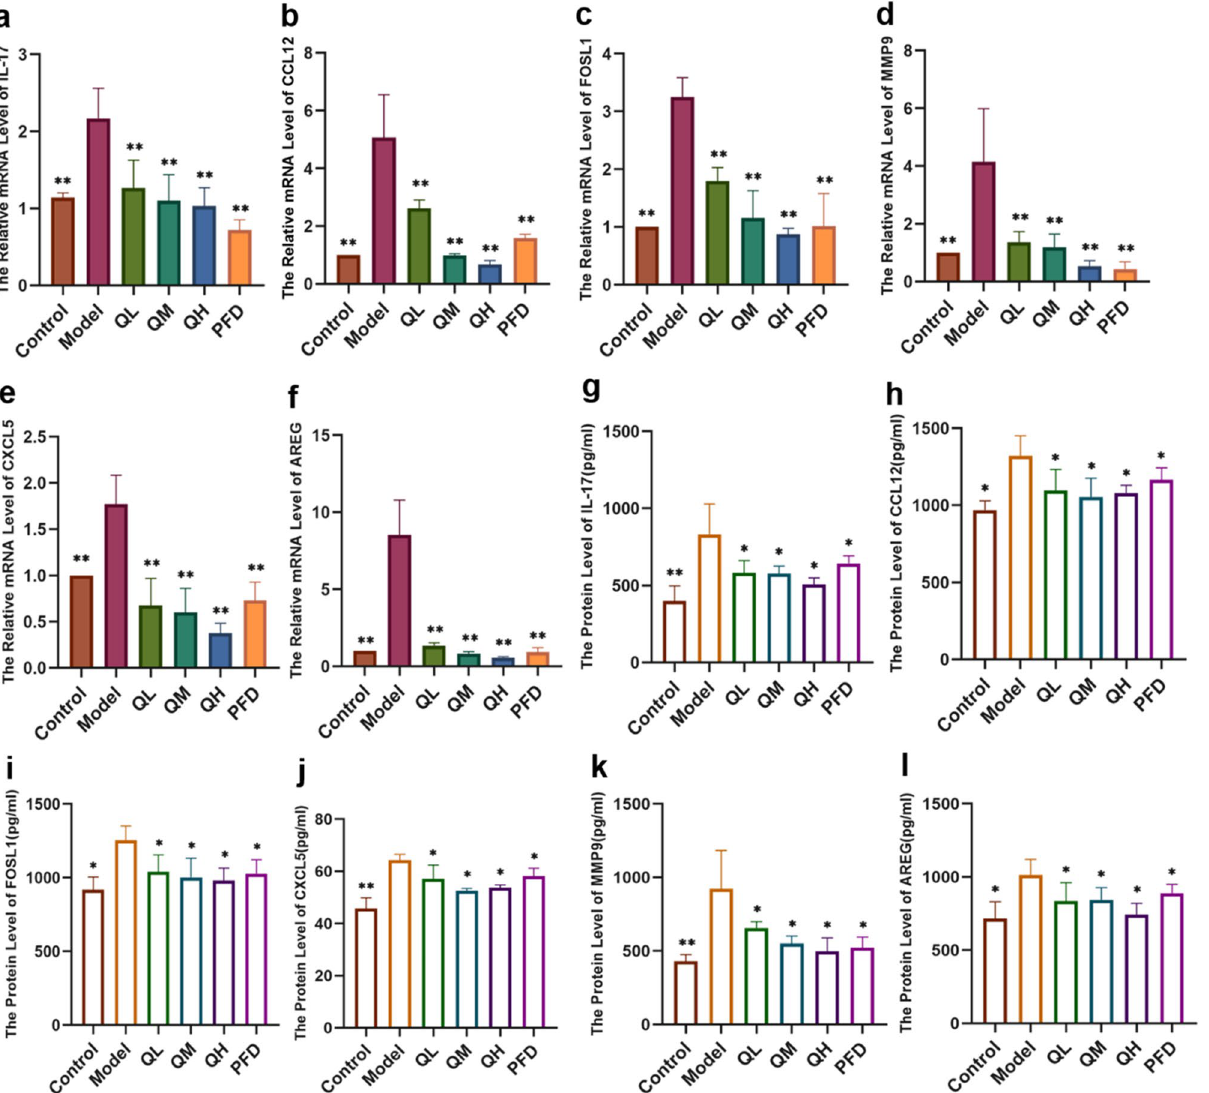
Figure 5. The influence of QLT on IL-17 signal transduction pathway. qRT-PCR was used to verify the mRNA levels of ( a ) IL-17, ( b ) CCL12, ( c ) FOSL1, ( d ) MMP9, ( e ) CXCL5 and ( f ) AREG in pulmonary tissues. Elisa was used to verify the protein levels of ( g ) IL-17, ( h ) CCL12, ( i ) FOSL1, ( j ) MMP9, ( k ) CXCL5 and ( l ) AREG in pulmonary tissues. The data shown are Mean ± SEM of 3 independent experiments. (n = 3; data are expressed as mean ± SD. * P < 0.05 ** P < 0.01, compared with Model